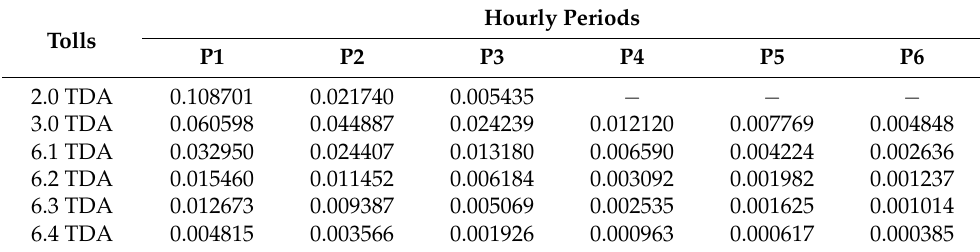
Table 1. Prices of energy in Spain, in euros per kWh, for each hourly period and type of transport and distribution toll ( Te p ), corresponding to the year